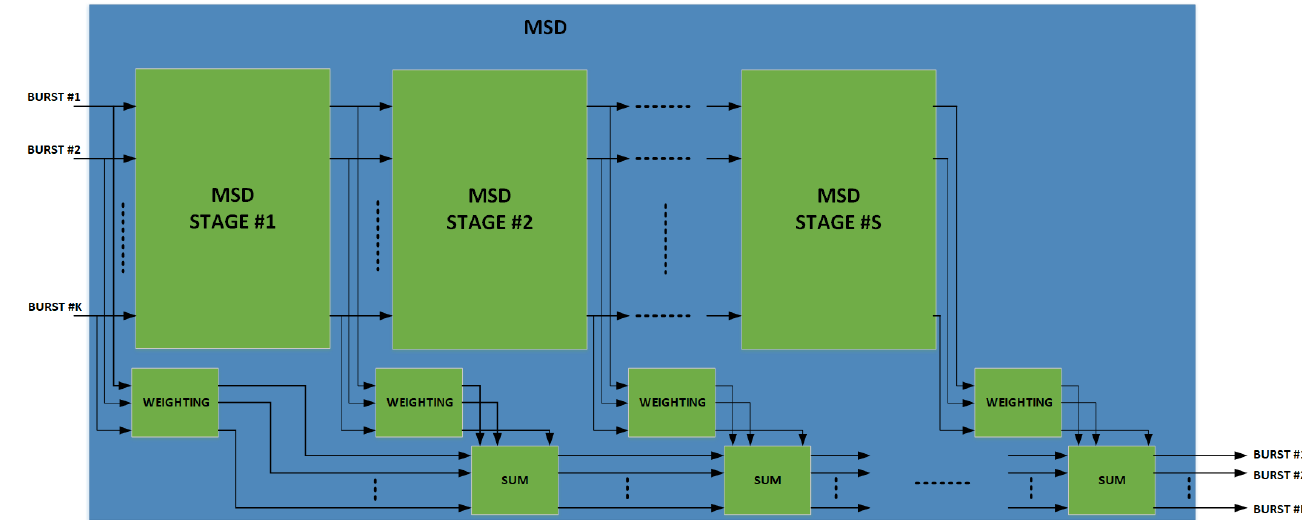
Figure 8. Multistage despreader architecture.